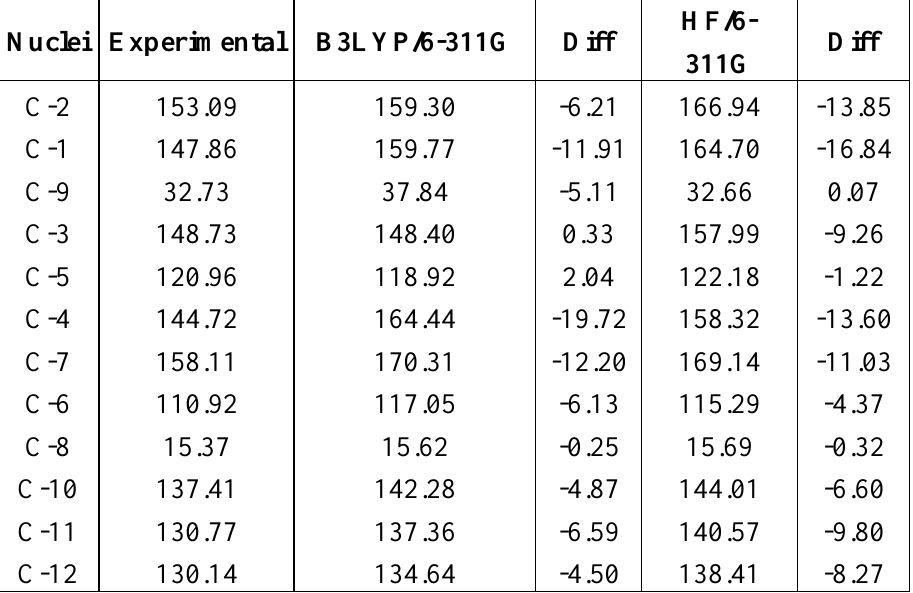
Table 3. Comparision between experimental and calculated chemical shifts (ppm) of 2c